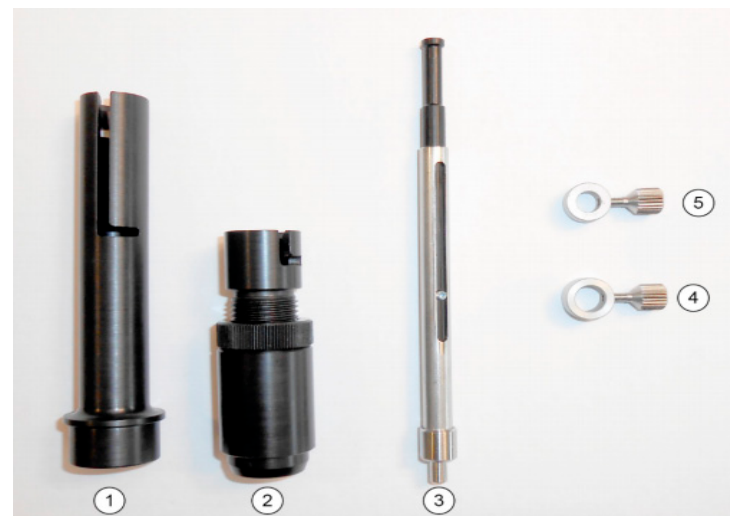
Figure 2. Restek PAL traditional SPME fiber and SPME Arrow manual extraction and injection kit. ( 1 ) Extraction guide; ( 2 ) injection guide; ( 3 ) Arrow / fiber syringe; ( 4 ) large inner diameter (ID) locking screw; and ( 5 ) small ID locking screw.